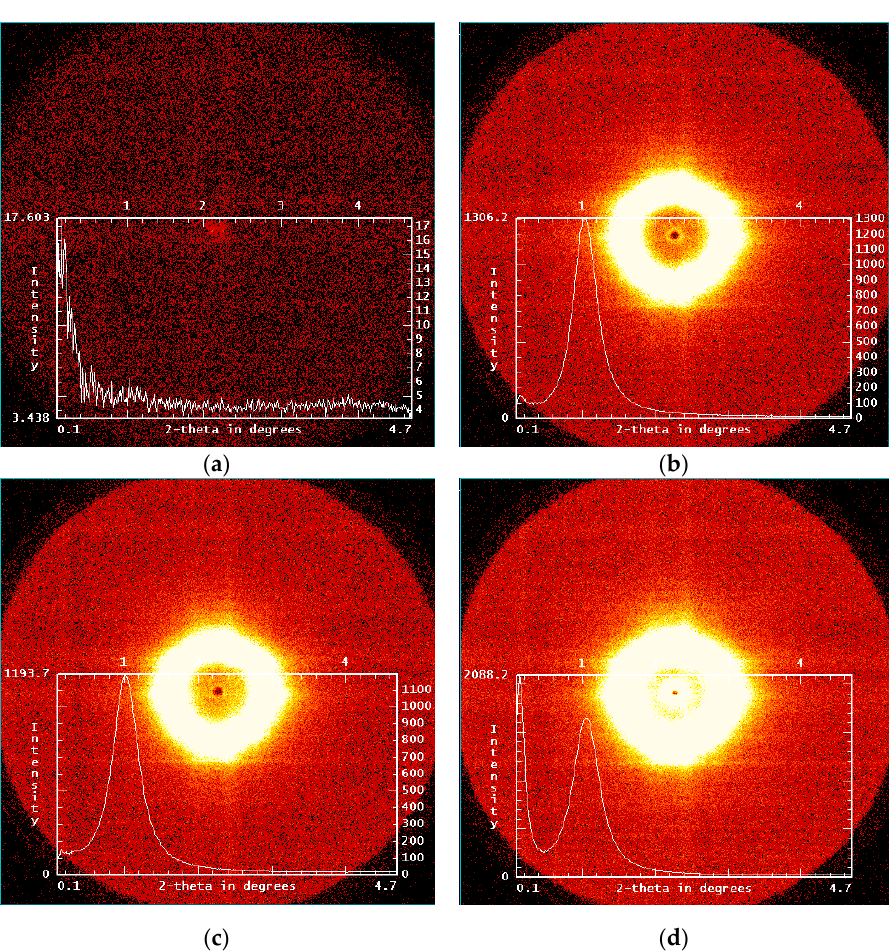
Figure 11. Screenshots of the 2-D SAXS patterns: ( a ) background scattering and ( b ) POI-Gl-POSS-0.1, ( c ) POI-Gl-POSS-10, and ( d ) POI-Gl-POSS-15. Membranes 2020 , 10 , x FOR PEER REVIEW